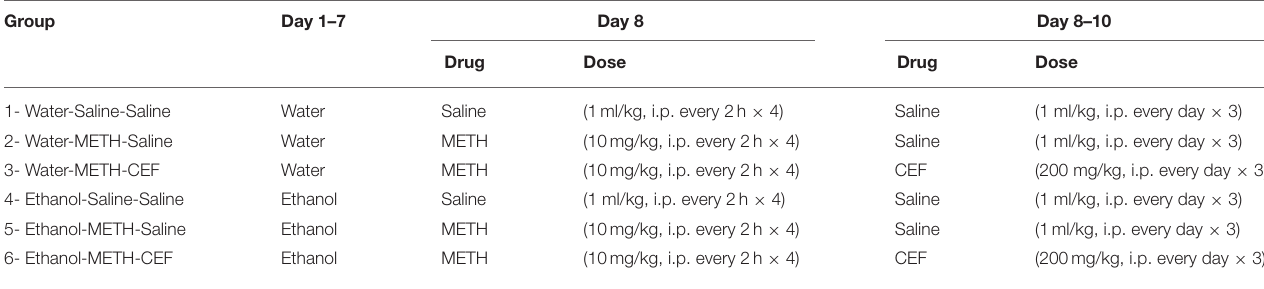
TABLE 1 | Experimental groups according to the administration of water or ethanol oral gavage, METH or saline, as well as CEF or saline.